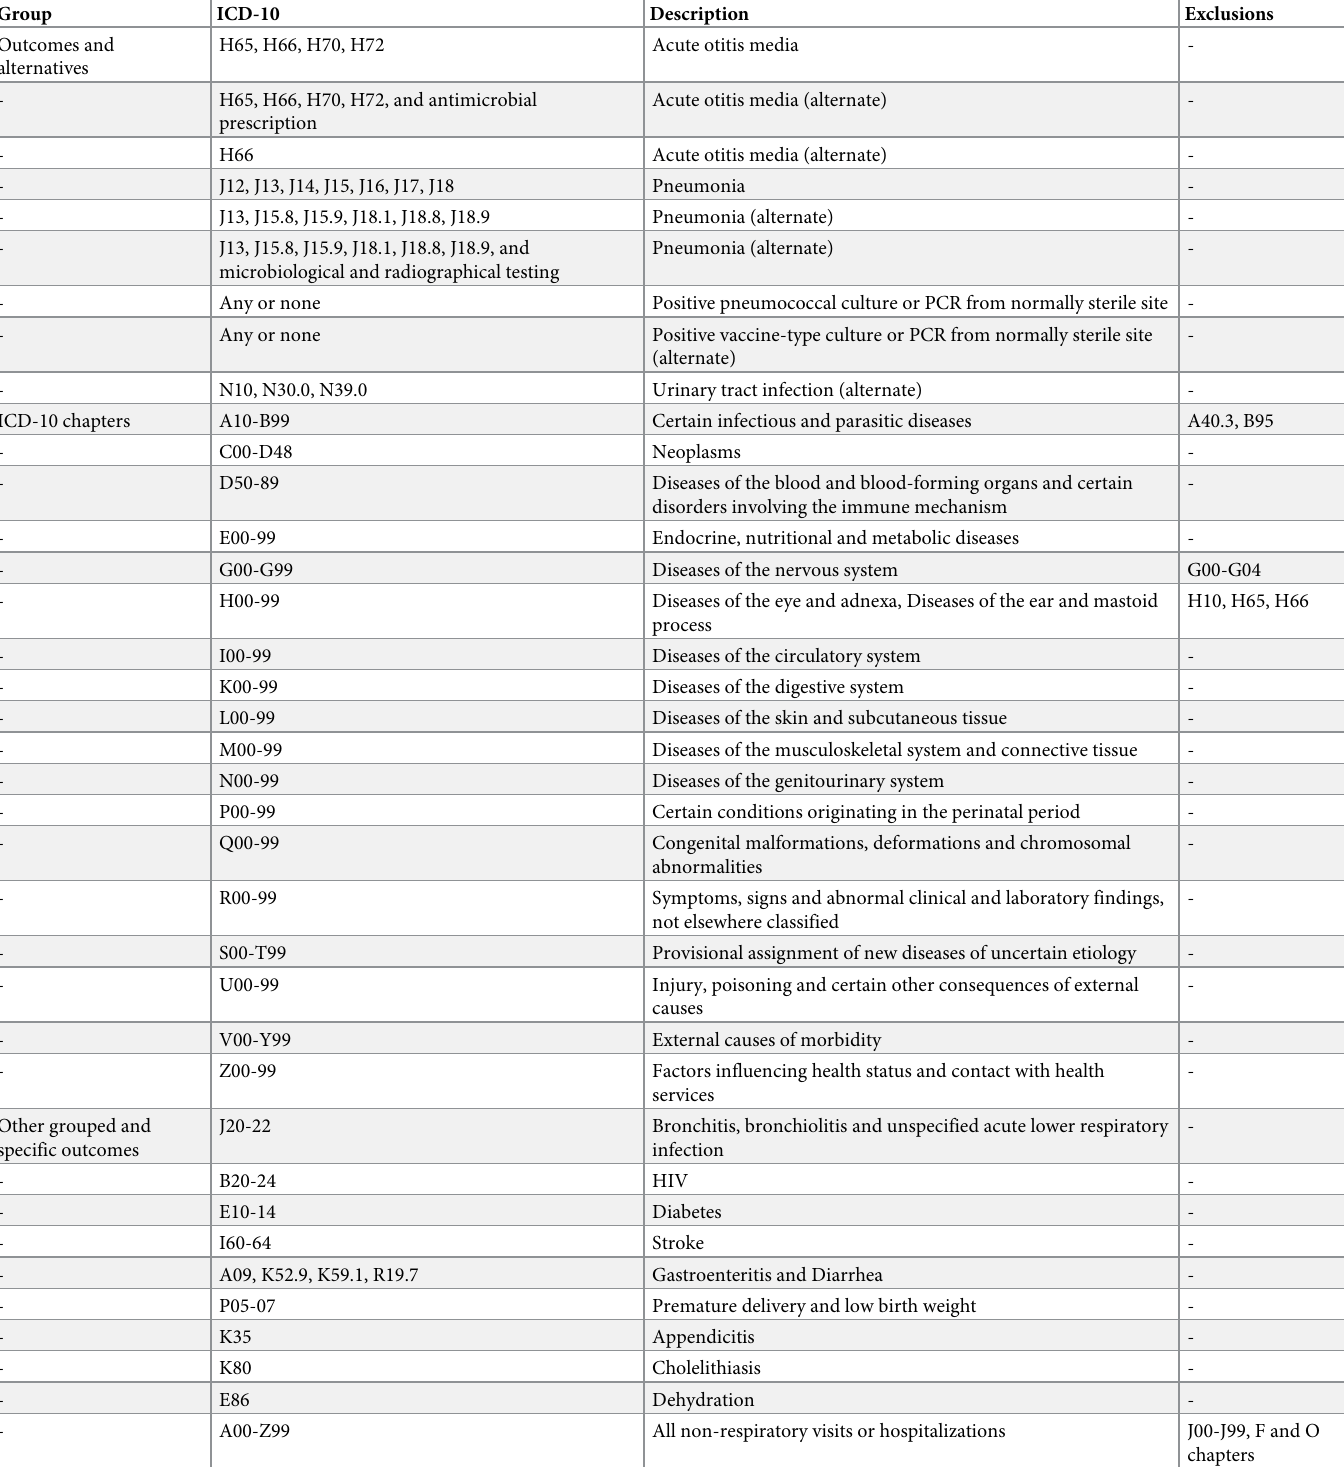
Table 1. The International Classification of Diseases, 10th revision (ICD-10) codes used to define disease states and synthetic controls used in the time series